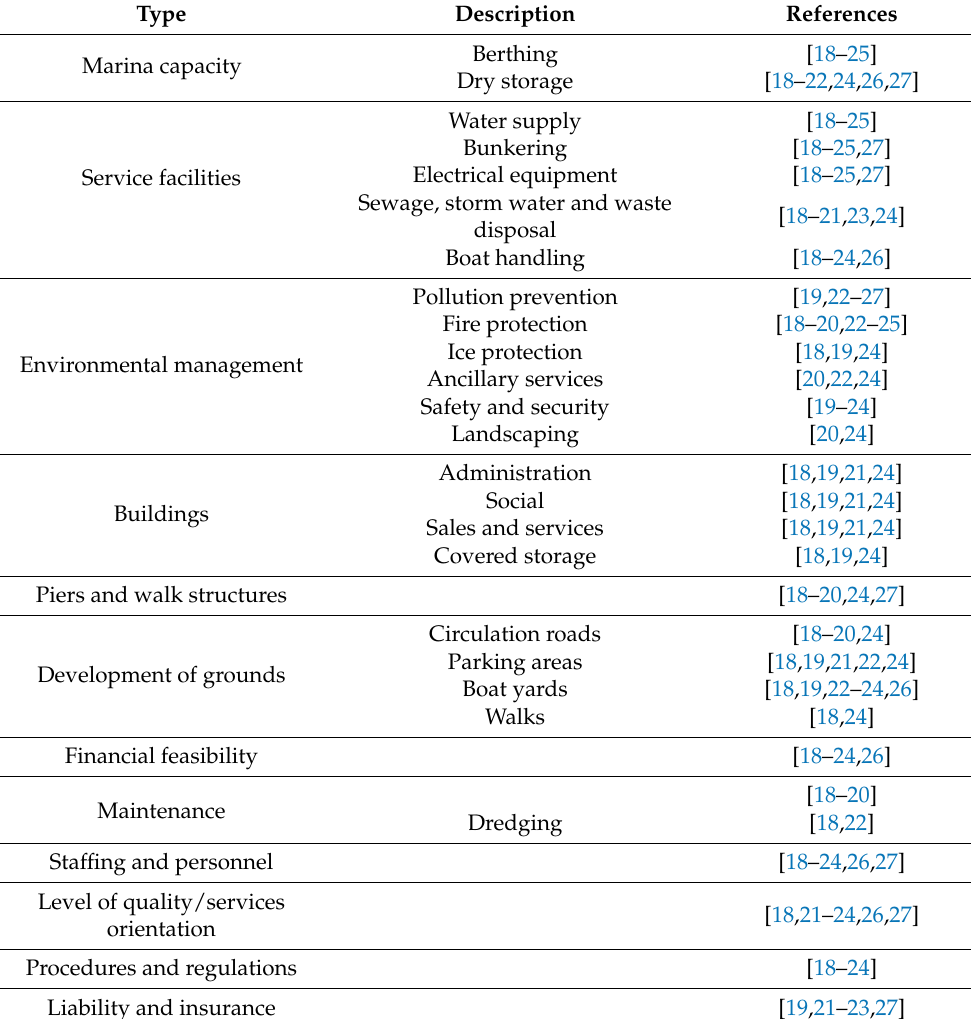
Table 1. Marina management relevant